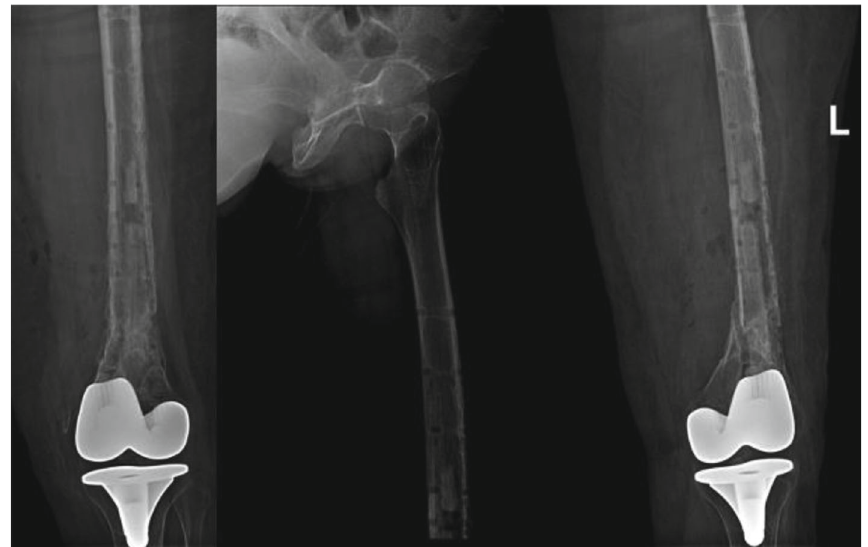
Figure 9: Postoperative radiographs two months after hardware removal showing complete healing of the fracture with satisfactory